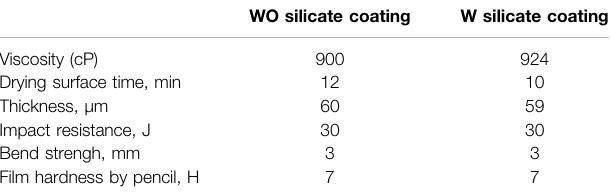
TABLE 4 | The mechanical properties of WO and W silicate